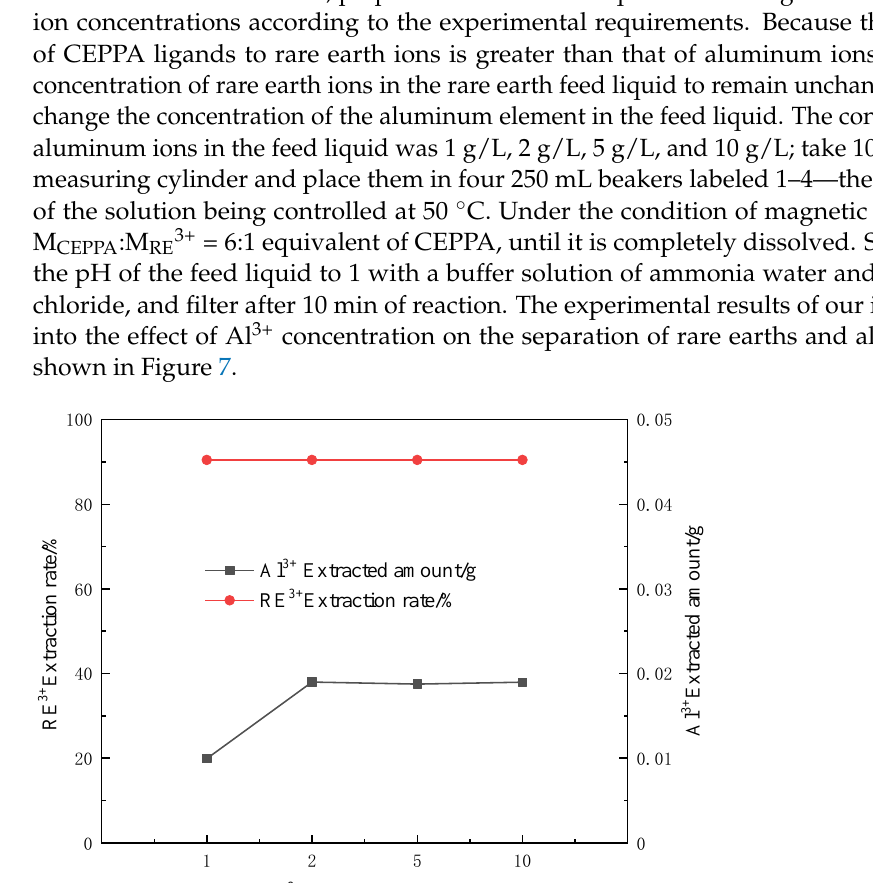
Figure 8. XRD characterization of a complex product after roasting. The red line PDF card in Figure 8 is the standard PDF card for Y(PO 3 ) 3 , It can be seen that the white solid obtained in the previous experiment is Y(PO 3 ) 3 after calcination, which verifies the conjecture that it is a complex product of Y 3+ and CEPPA.